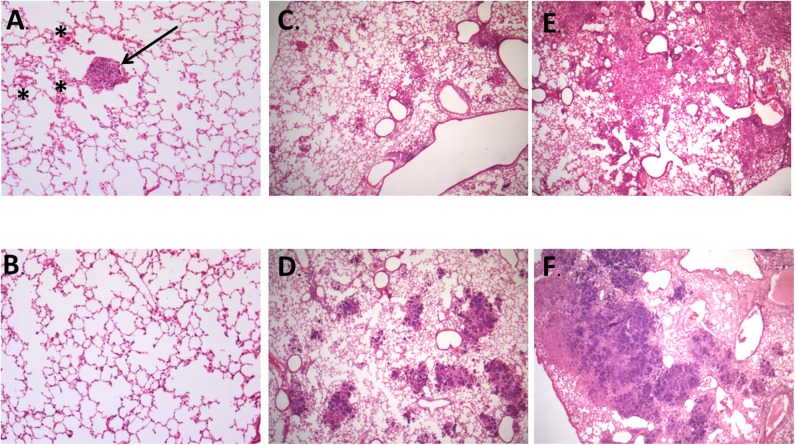
Representative images of histopathological findings in animals infected by strain 46 and strain 46P. (A) Animals infected by strain 46 had early formation of granulomas (arrow) and interstitial inflammation, since day 7 post-infection (100X magnification). (B) Representative image of animals infected by strain 46P at day 7 postinfection, without formation of granulomas and very scarce if any interstitial inflammation (100X magnification). (C) On day 21 postinfection, animals infected by strain 46 had small pneumonic areas throughout the lung tissue (25X magnification). (D) Animals infected by strain 46P, instead, had larger pneumonic and necrotic areas by day 21 postinfection (25X magnification). (E) By day 28 postinfection, animals infected by strain 46 had larger, confluent pneumonic areas, with scarce areas with necrosis (25X magnification). (F) Contrary, animals infected by strain 46P had large areas of massive pulmonary necrosis which occupied most of the lung tissue (25X magnification). Stained with hematoxylin and eosin. * areas of interstitial inflammation.